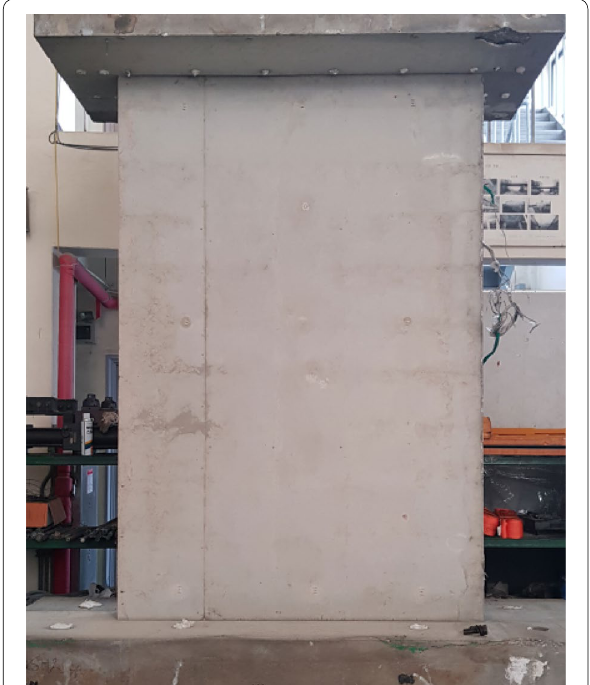
Fig. 7 Specimen QFH2 after the fire test.